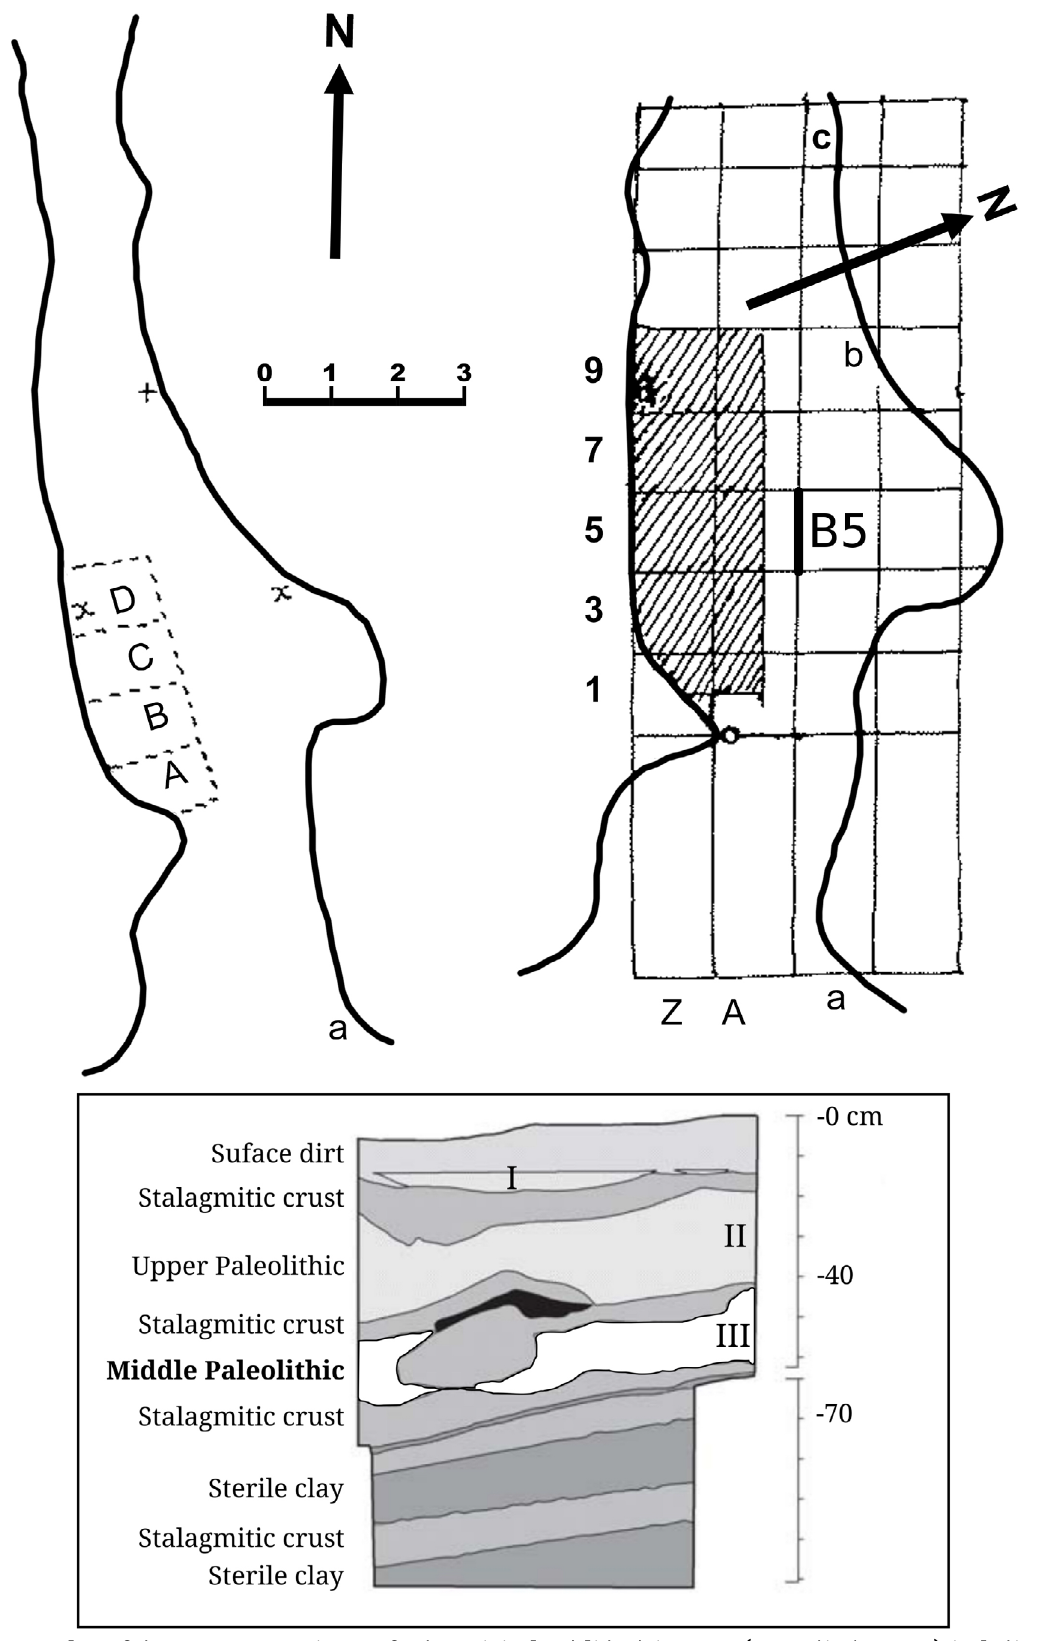
Figure 2. Plan of the 1931 excavation. Left: the original published in 1958 (Barandiarán 1958) including the excavated sectors and the position of the decorated panels. Right: the variation published in 1978 (Barandiarán 1978). Below: Synthetic stratigraphy obtained in the recent excavations (modified from Murelaga et al.